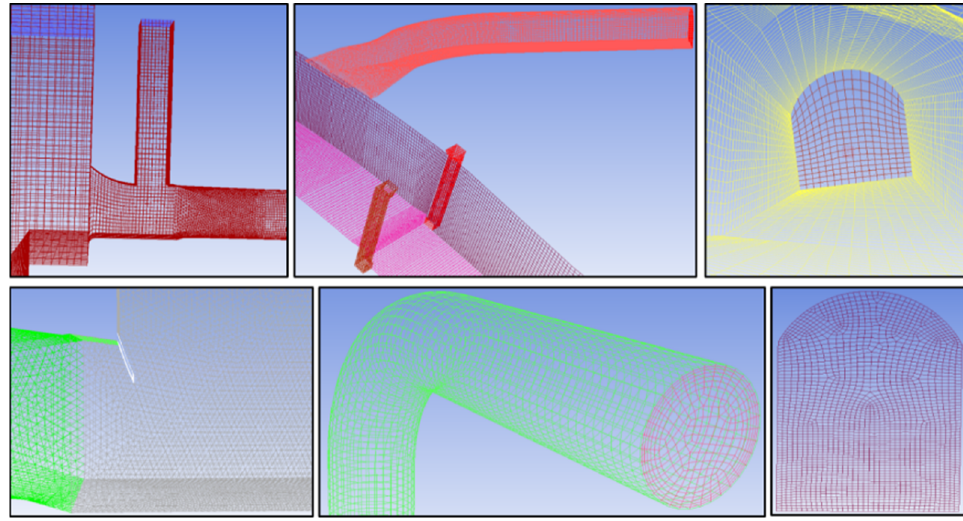
Figure 2. Mesh of Jinping-I spillway tunnel model.